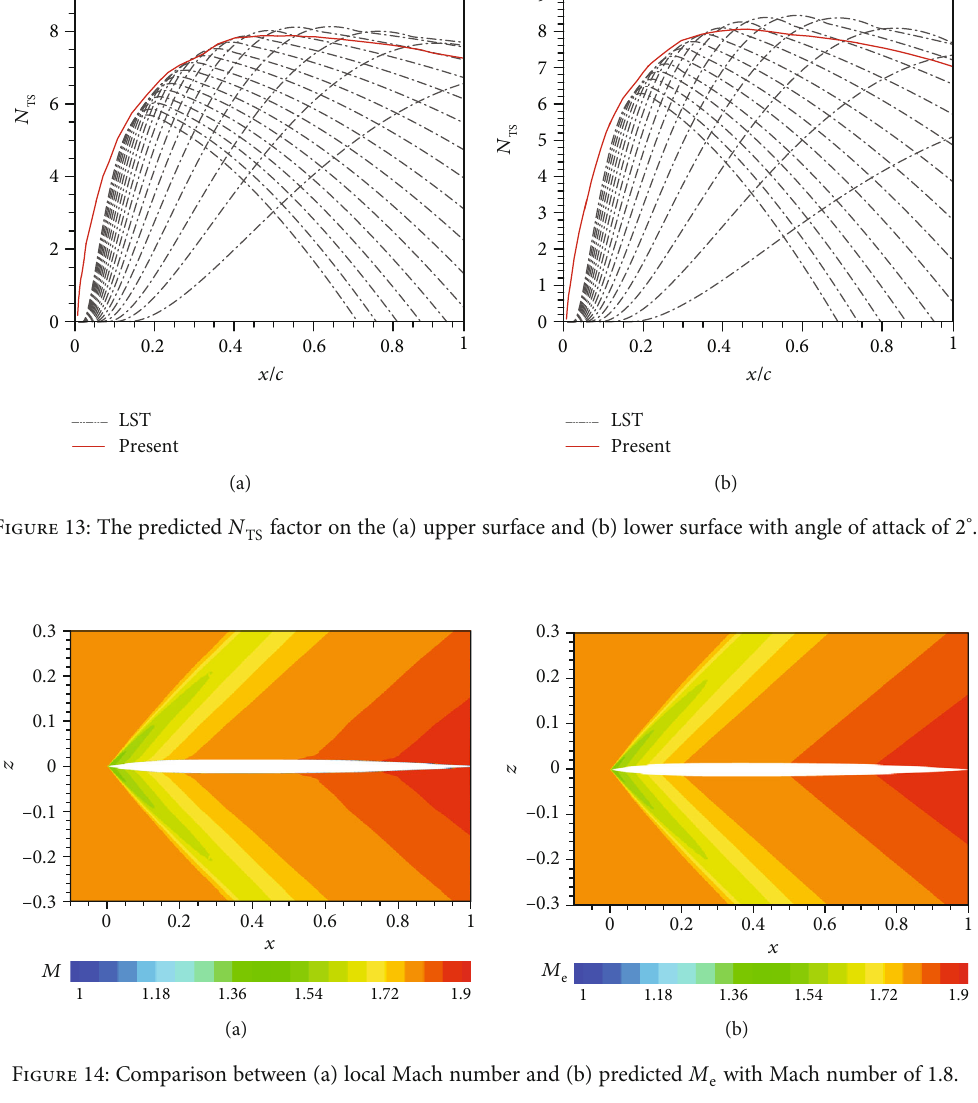
with Mach number of 1.8. e